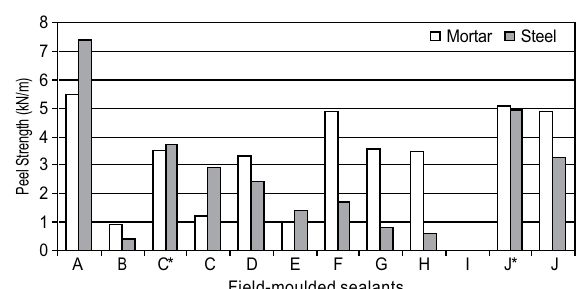
Fig. 1. Comparison of peel strength of various FMS adhered to mortar and steel